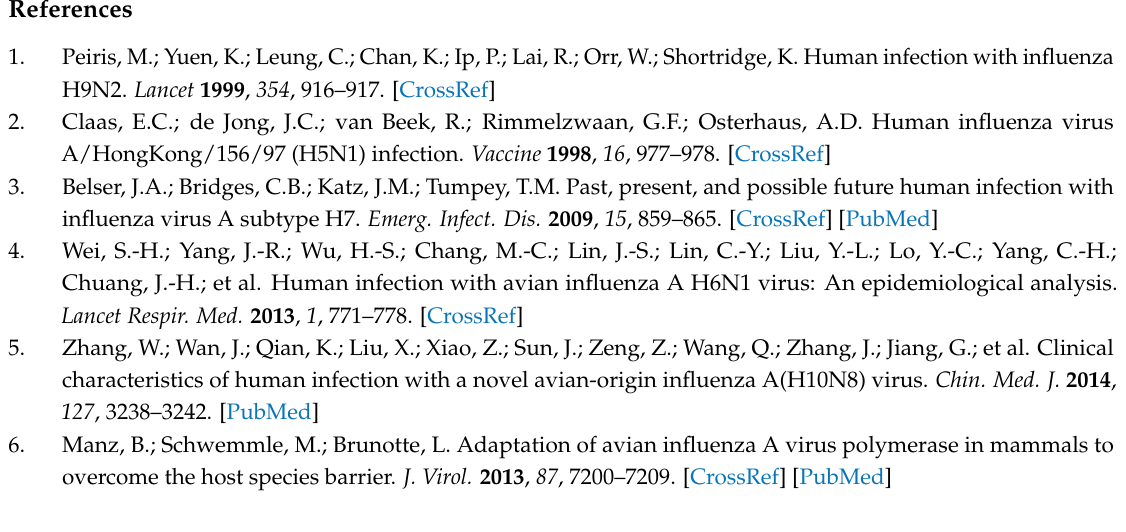
Figure S1: Deglycosylation of HA caused by of HA caused by mutaton.